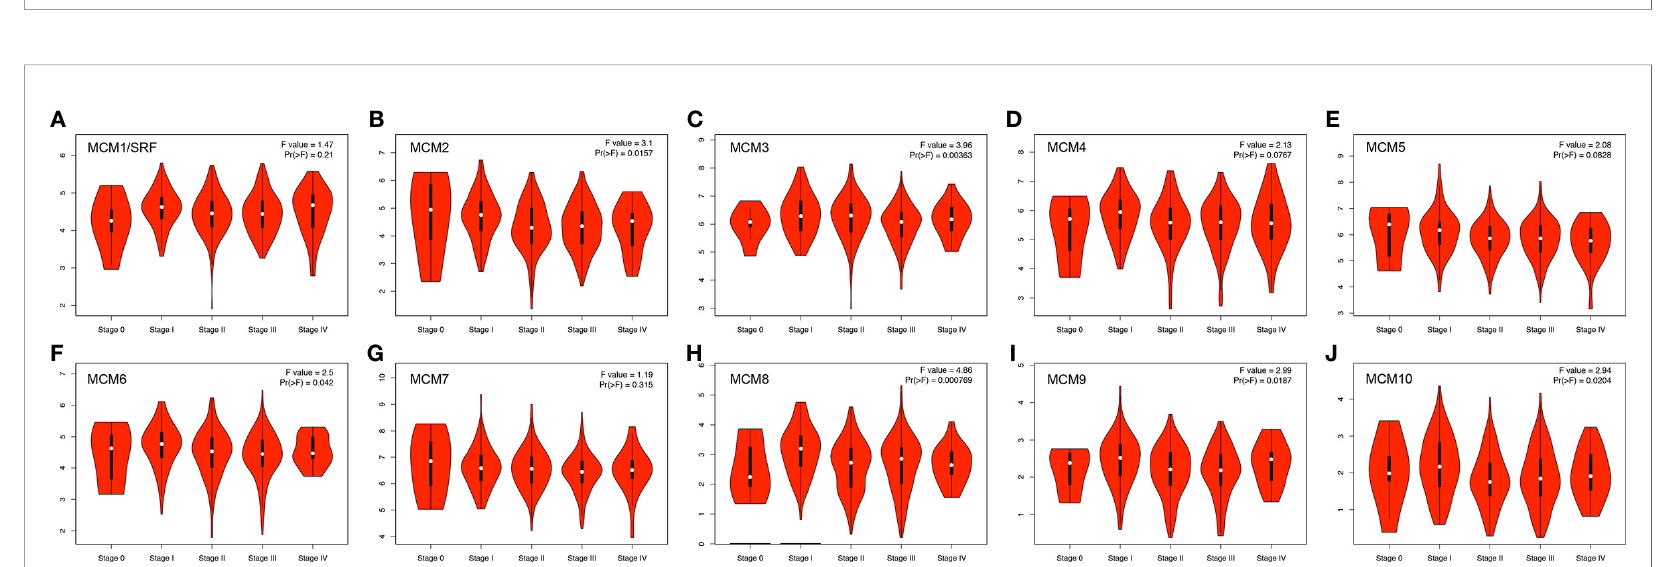
FIGURE 3 | Transcriptional expression of MCM s in different sample types of melanoma. (A – J) Except MCM7 , MCM1 – 6 and MCM8 – 10 were all overexpressed in metastatic melanoma than in primary melanoma in the TCGA cohort ( p < 0.05).